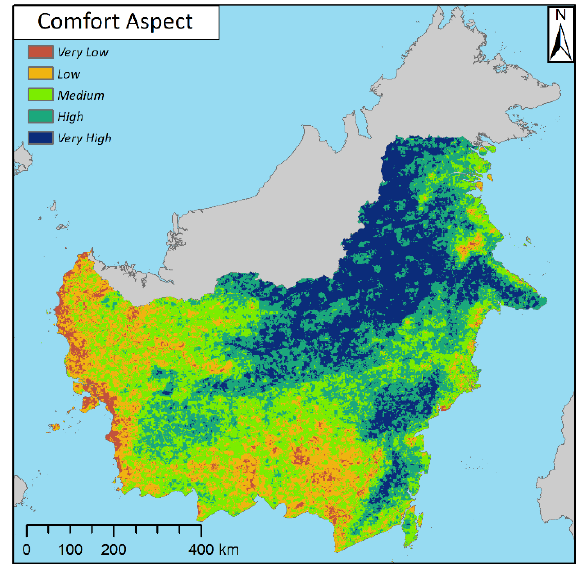
Figure 4 . Comfort